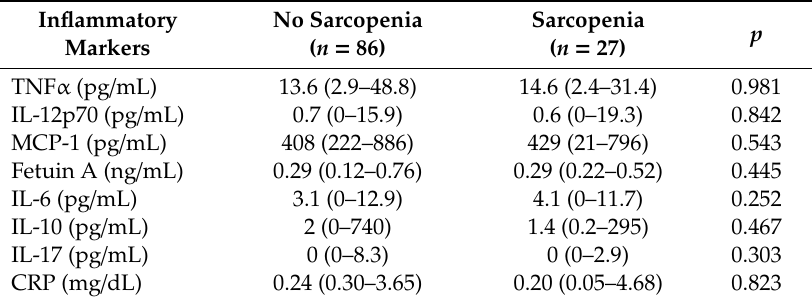
Table 5. Inflammatory markers in non-sarcopenic and sarcopenic